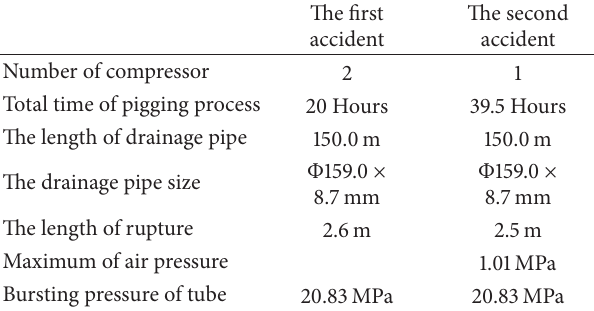
Table 2: Summary of two